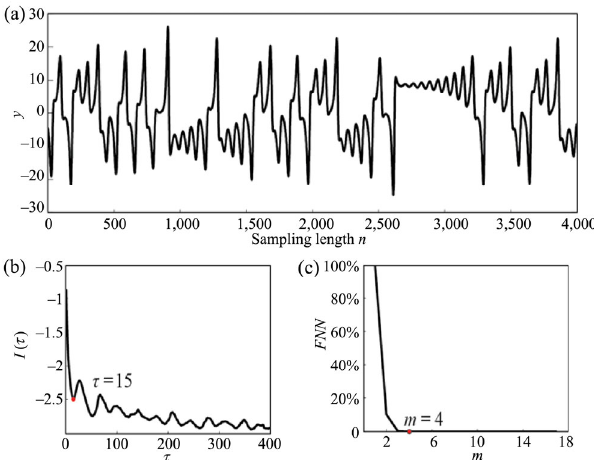
Fig. 4 One-dimensional time series y of the Lorenz system and embedding parameters.